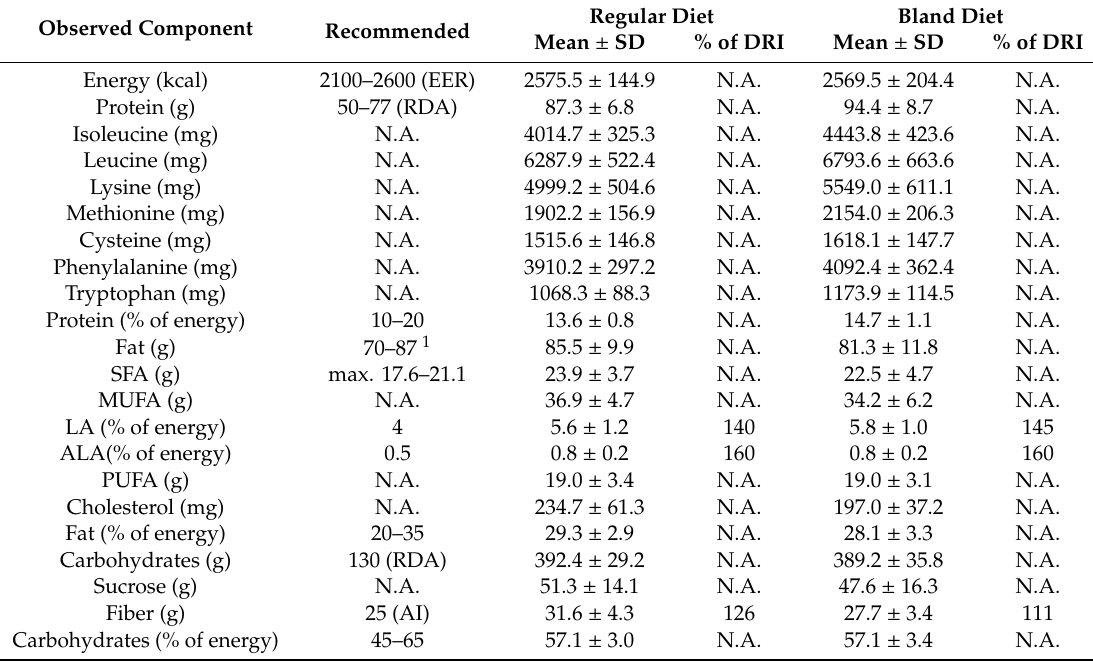
Table 1. Energy and macronutrients provided in prisons ( n = 30) menus per person per day and the age-specific dietary reference intake